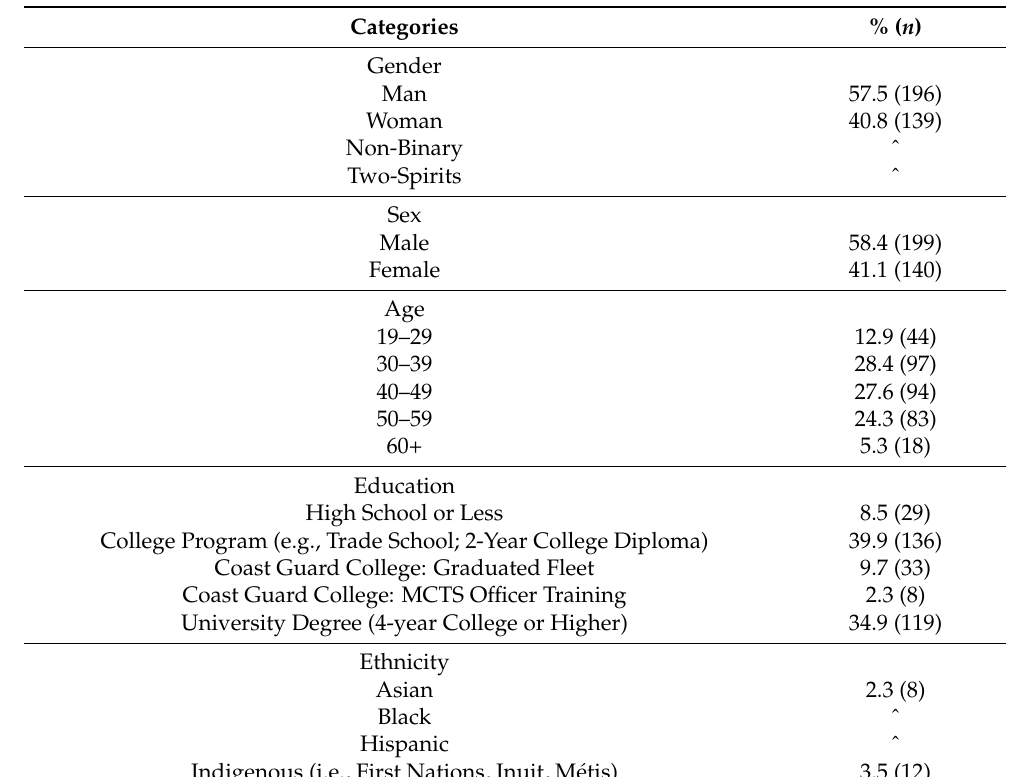
Table 1. Participant Sociodemographics Information and Distribution ( n =